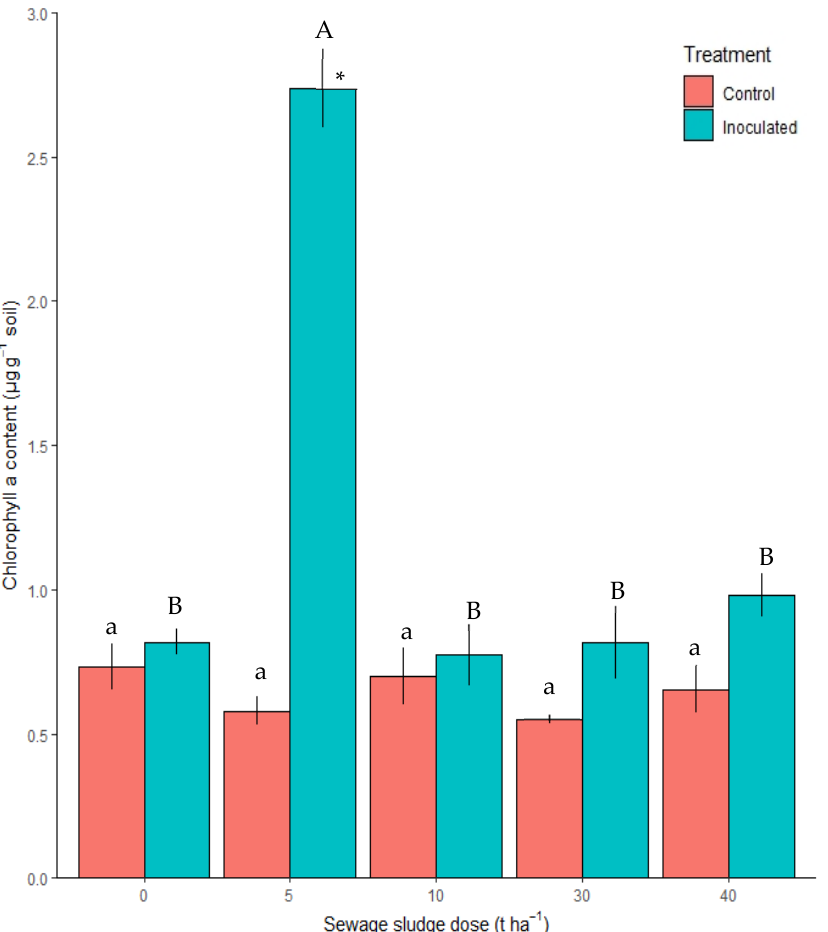
Figure 2. Chlorophyll a concentration ( µ g g − 1 soil) in the control and inoculated samples for the different sewage sludge doses, after 4 months. Lowercase letters indicate significant differences among control treatments at the different SS doses, while capital letters indicate significant differences among inoculated treatments at the different SS doses. * indicates statistically significant differences between the control and the inoculated treatment for each sewage sludge dose.